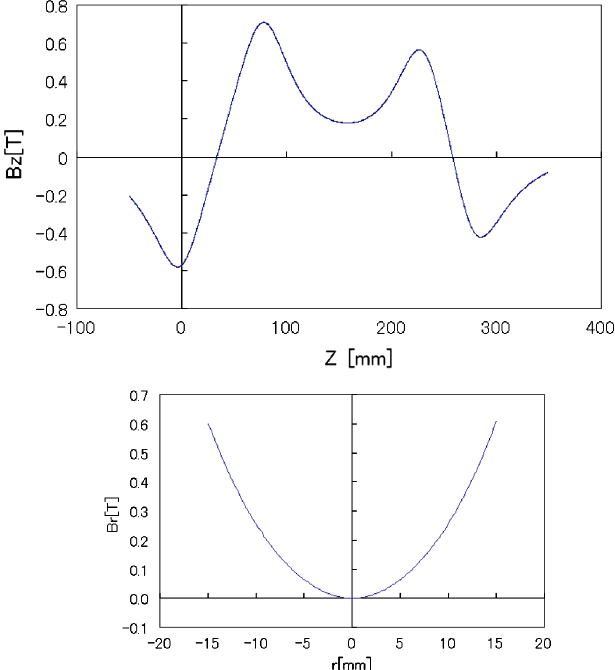
FIG. 4. Field distribution measured through the ECRIS, (top) z ) and (bottom) B B z (